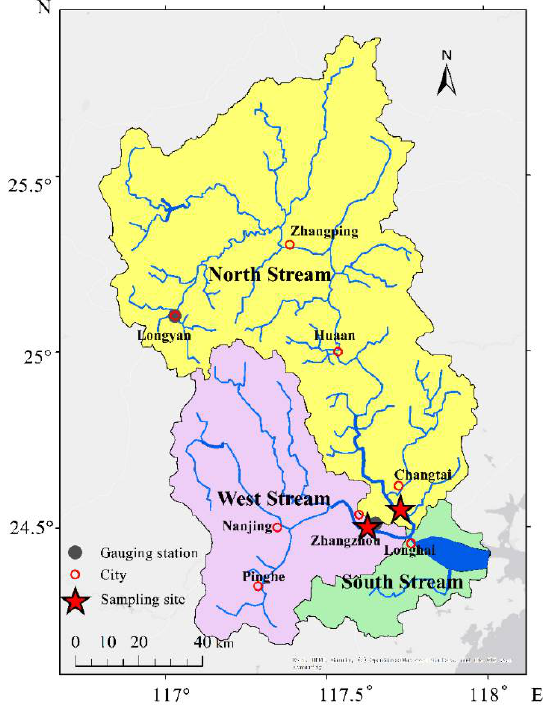
Figure 1. Sampling map. The precipitation data were collected from gauging stations (gray circles). The surface water samples were collected from the Guokeng Bridge on the NS and the Shuixianhua Bridge on the WS (red stars). The red circles represent surrounding cities in the watershed. Yellow, purple and green indicate the NS, WS and South Stream watersheds, respectively.